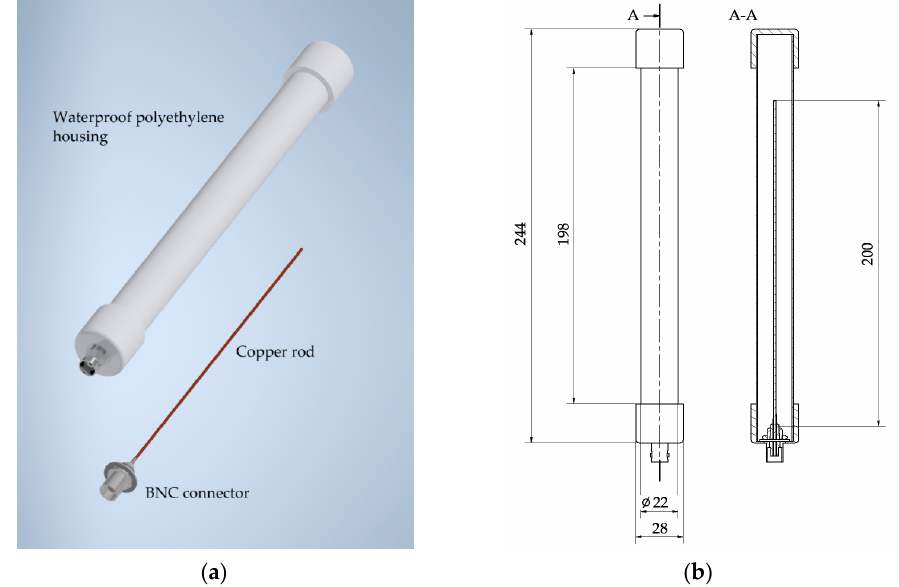
Figure 5. Construction of a capacitive probe for non-contact high voltage measurement: ( a ) 3D schematic diagram; ( b ) technical drawing with dimensions in mm.